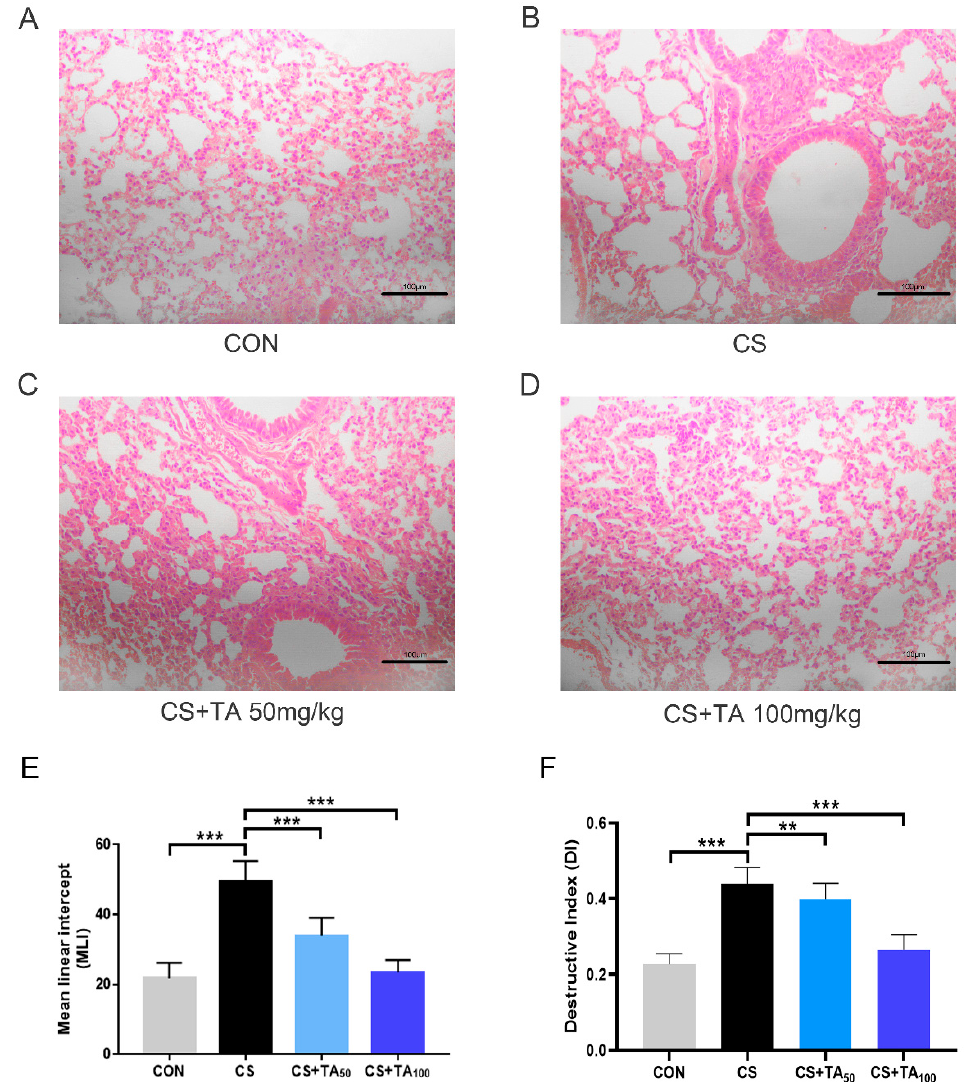
Figure 3. E ff ects of TA therapy on CS-induced pathological lung change. ( A – D ) Representative Figure 3. Effects of TA therapy on CS-induced pathological lung change. ( A–D ) Representative histopathological images (bar = 100 µ m) from di ff erent groups. ( E ) Mean linear intercept (MLI) and histopathological images (bar = 100 μ m) from different groups. ( E ) Mean linear intercept (MLI) and ( F ) destructive index (DI). ** p < 0.01, *** p < ( F ) destructive index (DI). ** P <0.01, *** P < 0.001.